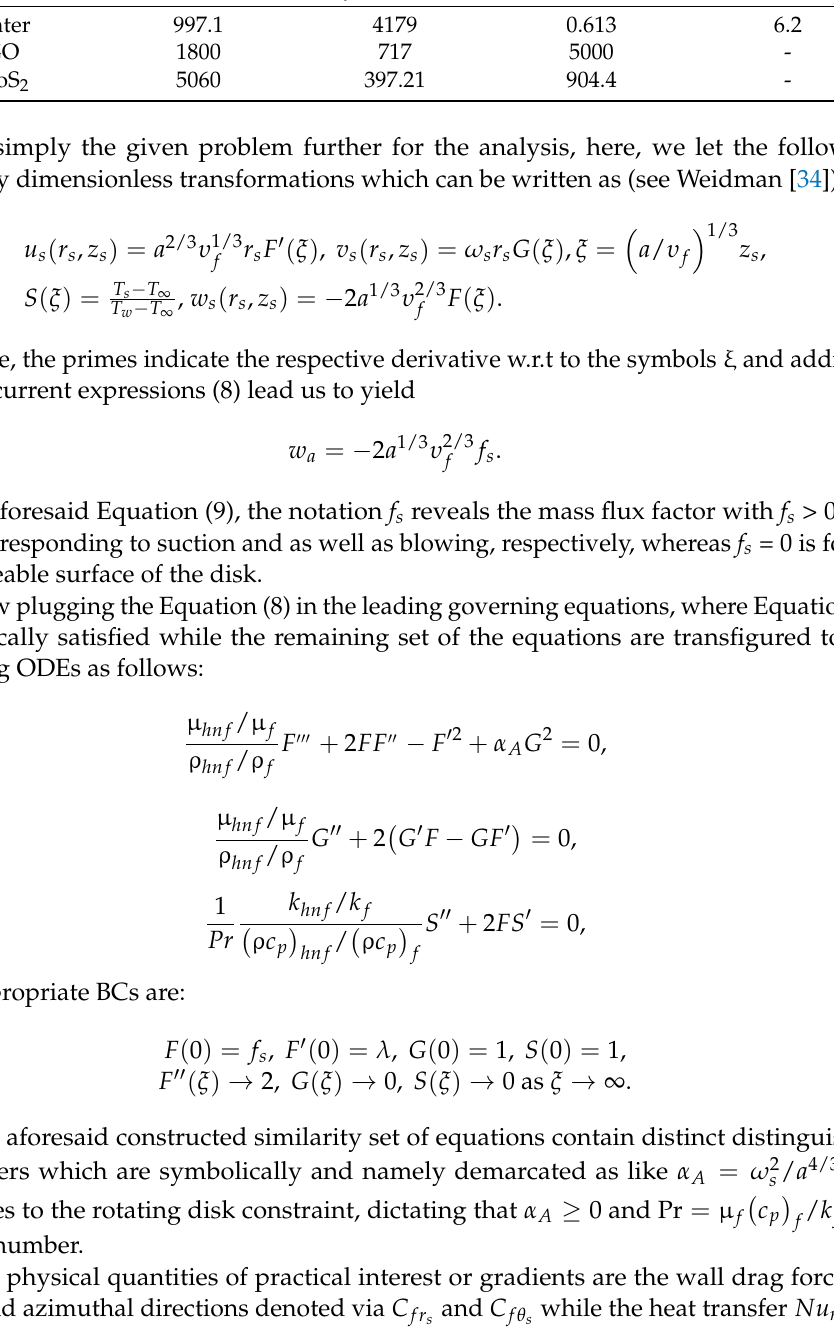
Table 1. The thermophysical properties of the (GO + MoS 2 )-H 2 O hybrid nanoparticles. (cid:0) (cid:1) c p ( J / ( kg . K )) Properties ρ kg / m 3 water 997.1